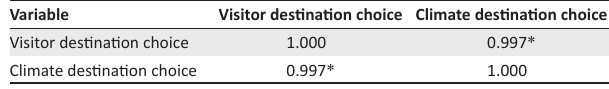
TABLE 6: Correlation between variables.